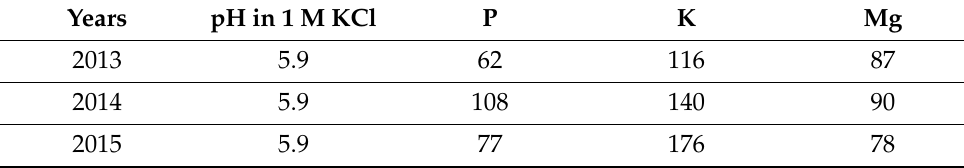
Table 1. Chemical composition of the soil during the years of